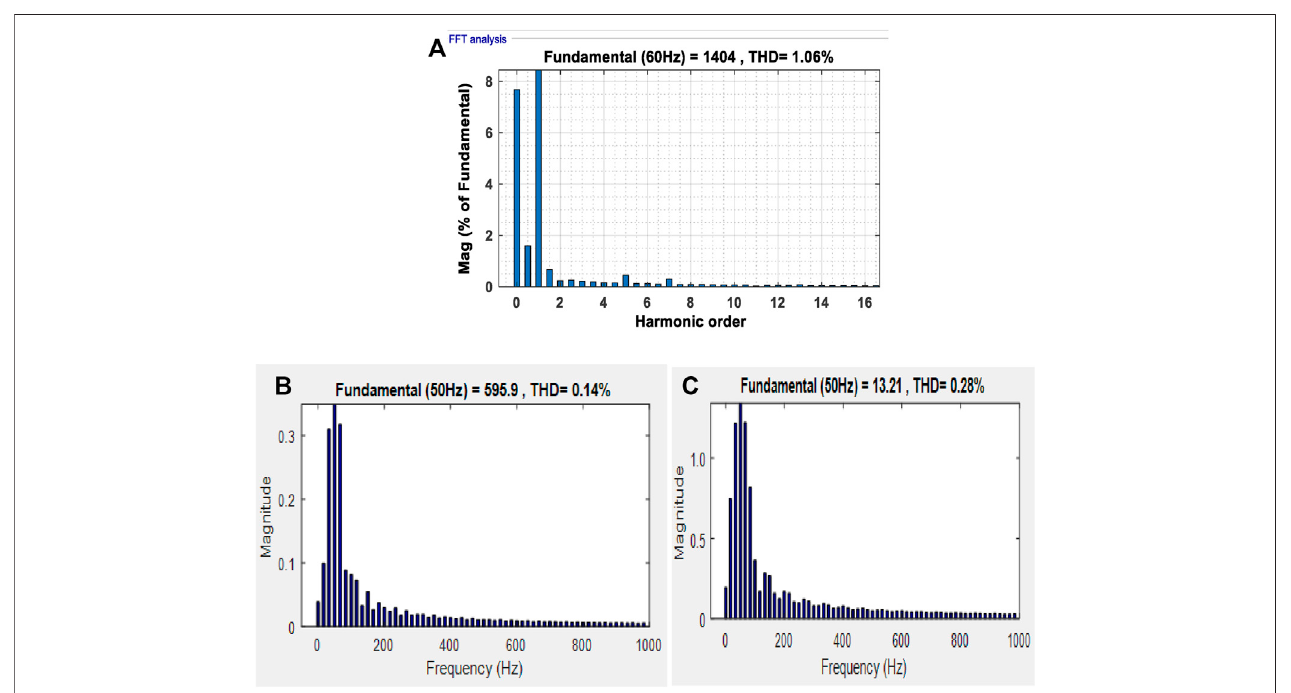
FIGURE 15 | (A) THD analysis after synchronized grid voltage. (B) THD of proposed HPGS voltages under RL load. (C) THD of proposed HPGS current under RL load.